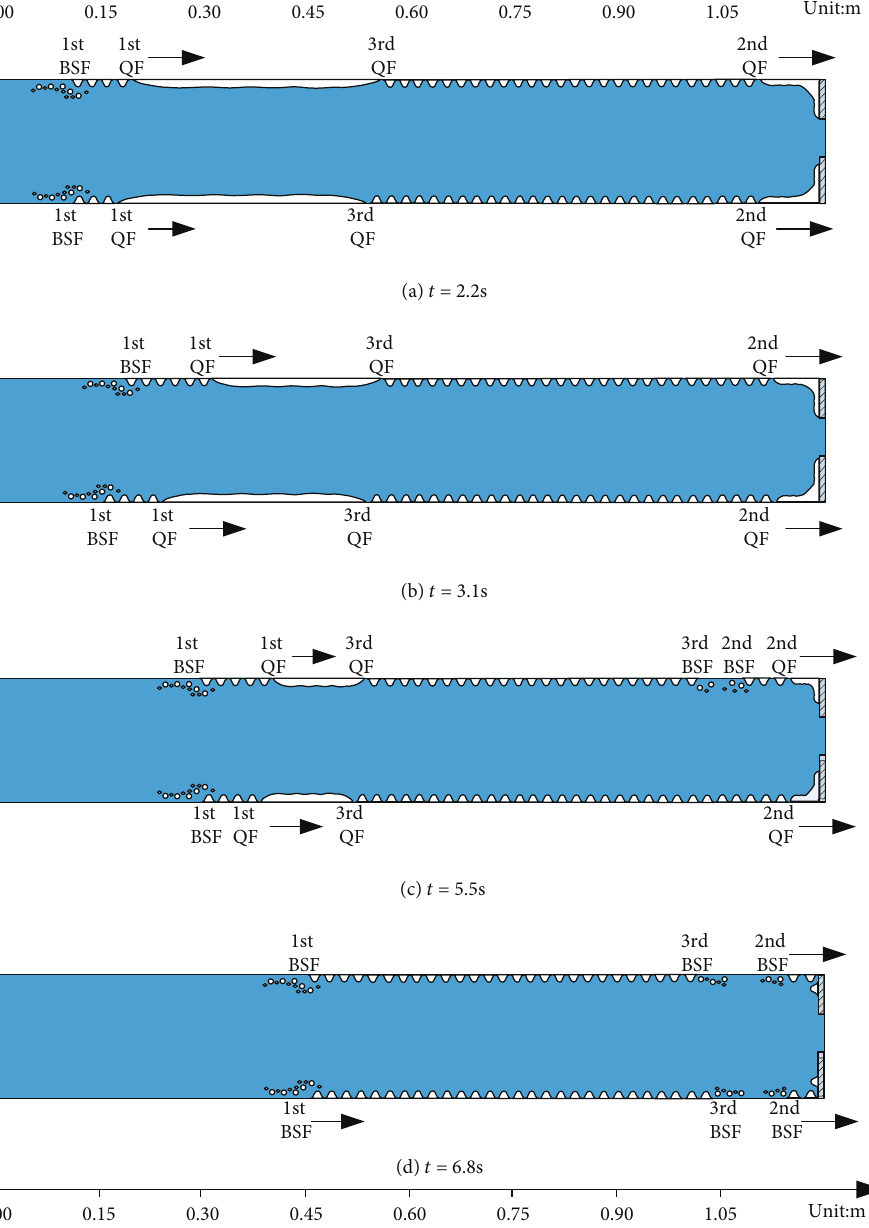
Figure 9: Flow patterns in the experimental section during the chill-down process for Exp.